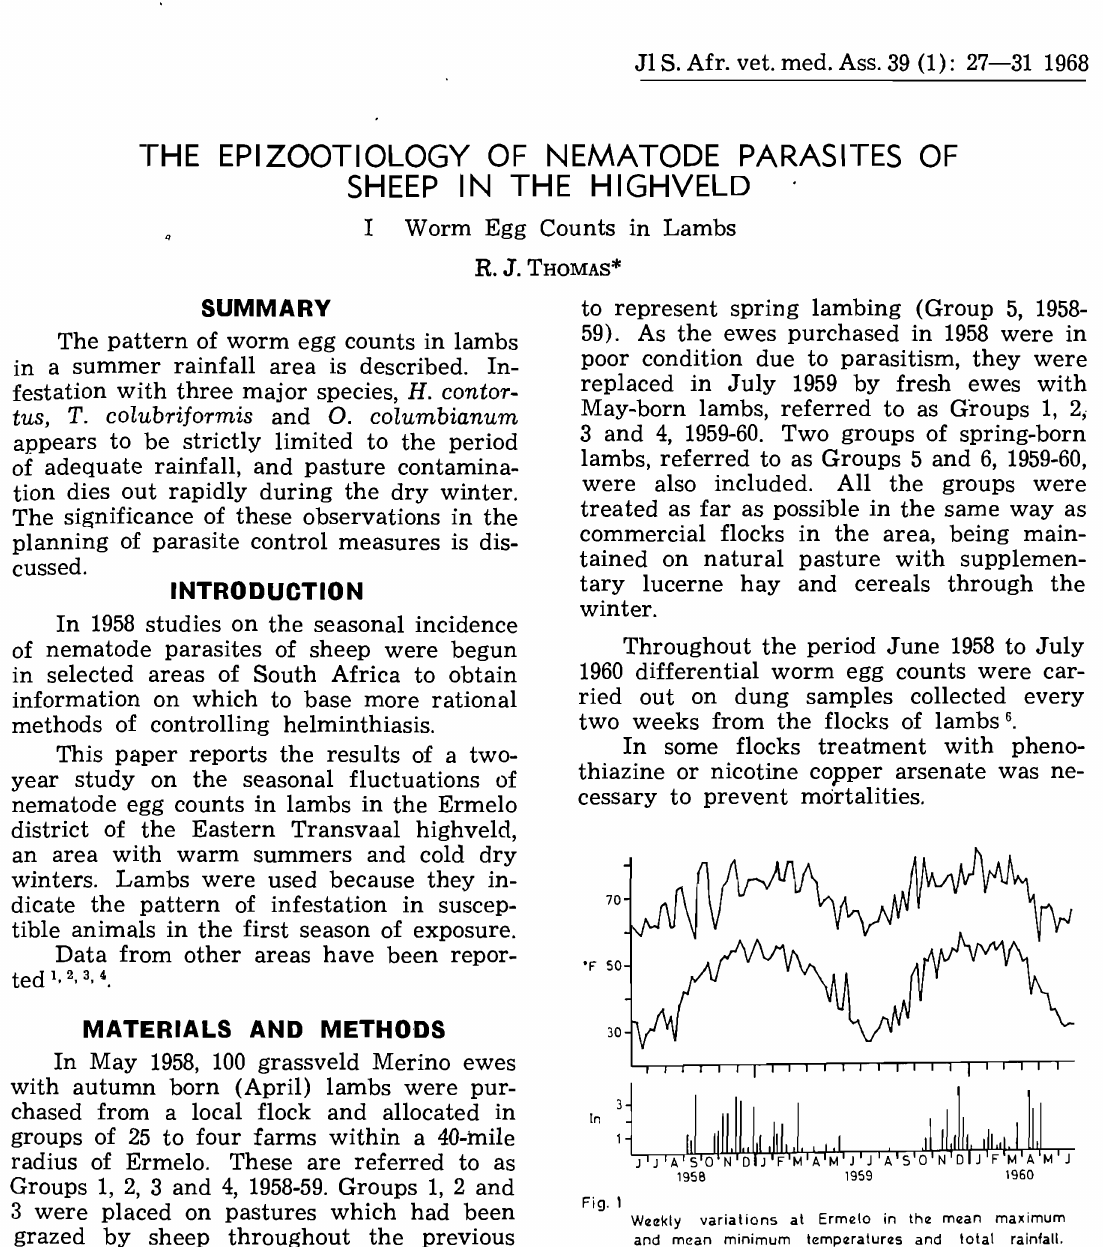
Fig. 1 Wczekly variations at ErmC!:lo in thez mean maximum and mean minimum tempczraturczs and total rainfall. Maximum and minimum temperatures and rainfall were recorded throughout the survey period (Fig. 1)